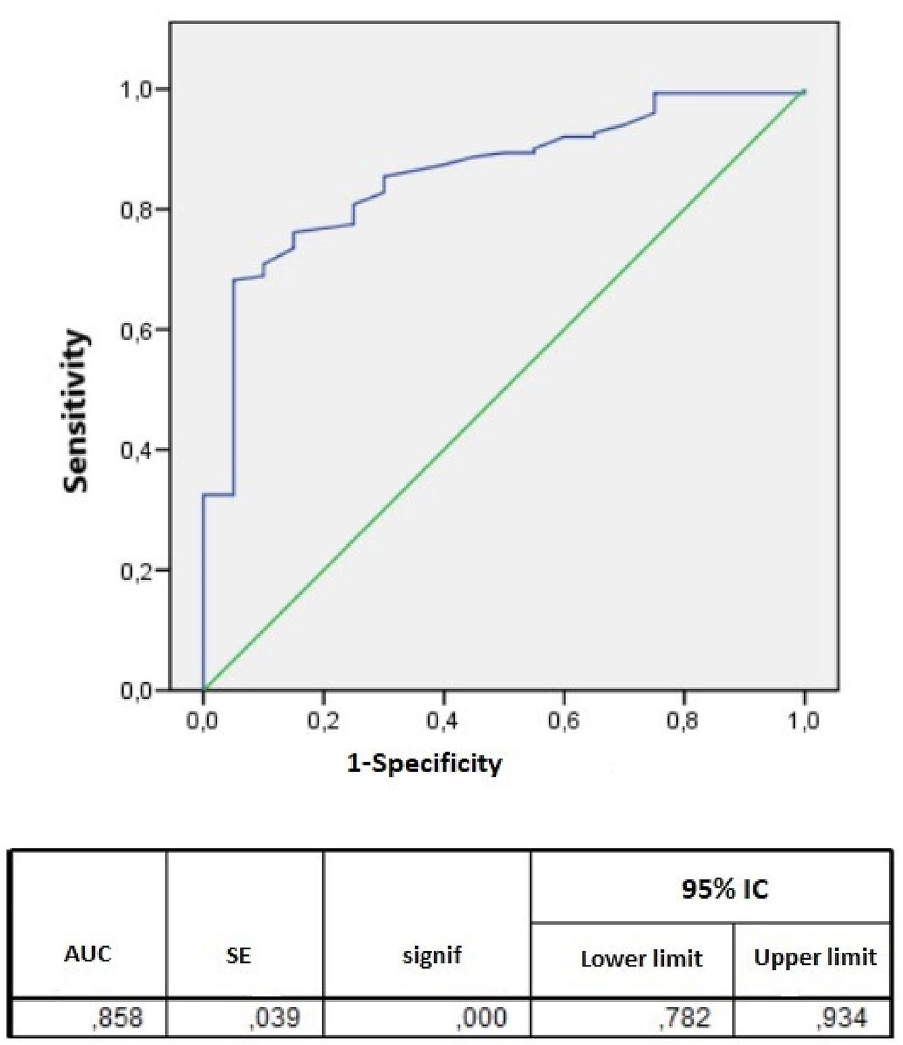
Figure 2. ROC curve for predictive regression